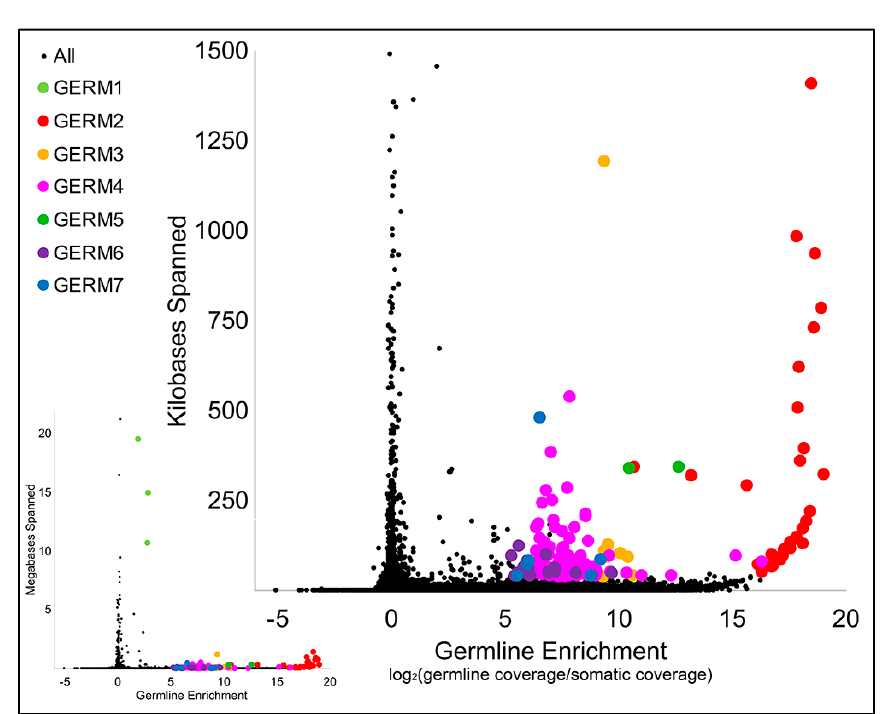
Figure 2. Estimates of the total genomic span and germline enrichment of repetitive sequences in the lamprey genome. The plot on the lower left shows enrichment values for the entire collection of reconstructed repetitive elements, including Germ1 . The larger plot on the upper right focuses on repeats that span < 1.5 megabases. Sequences belonging to repeat classes selected for hybridization are highlighted by colors corresponding to their repeat